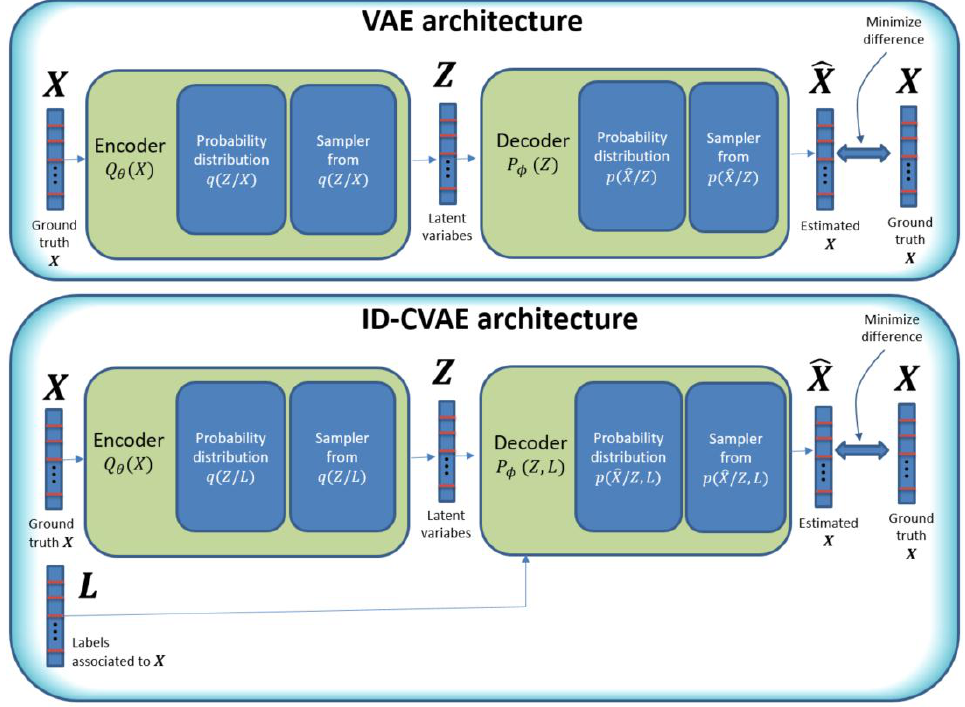
Figure 1. Comparison of ID-CVAE with a typical VAE architecture.